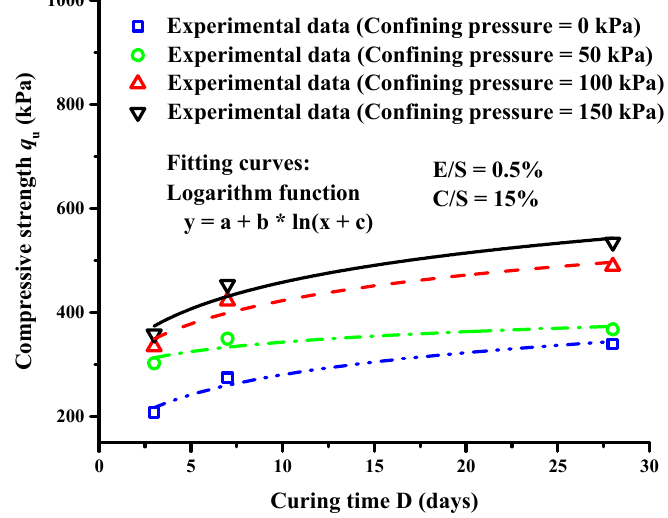
Figure 13. Compressive strength development of lightweight cement clay with curing time under different confining pressures. Table 3. Fittings of compressive strength and curing time under different confining pressures.